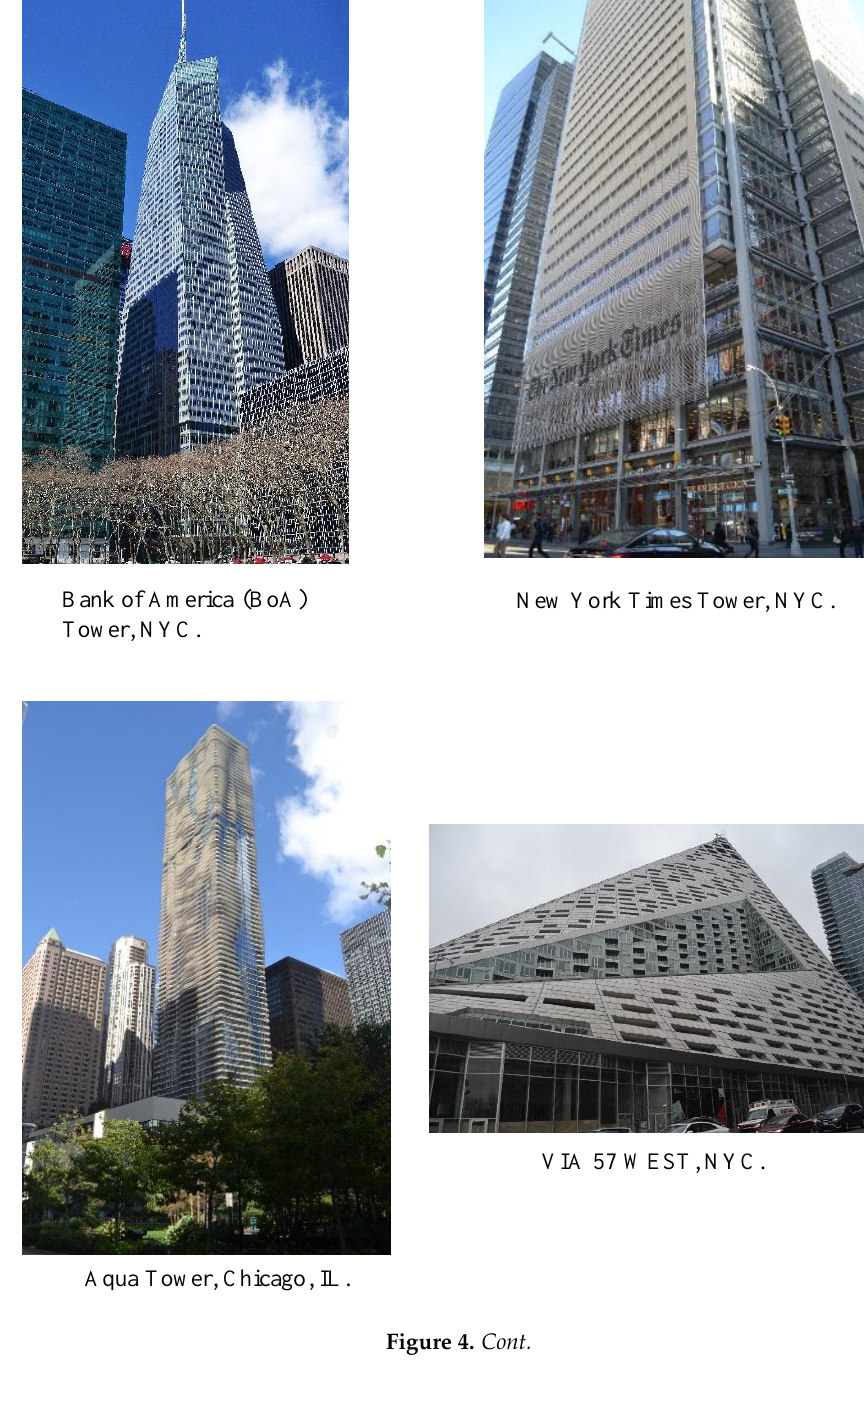
Figure 4. Figure 4. North America